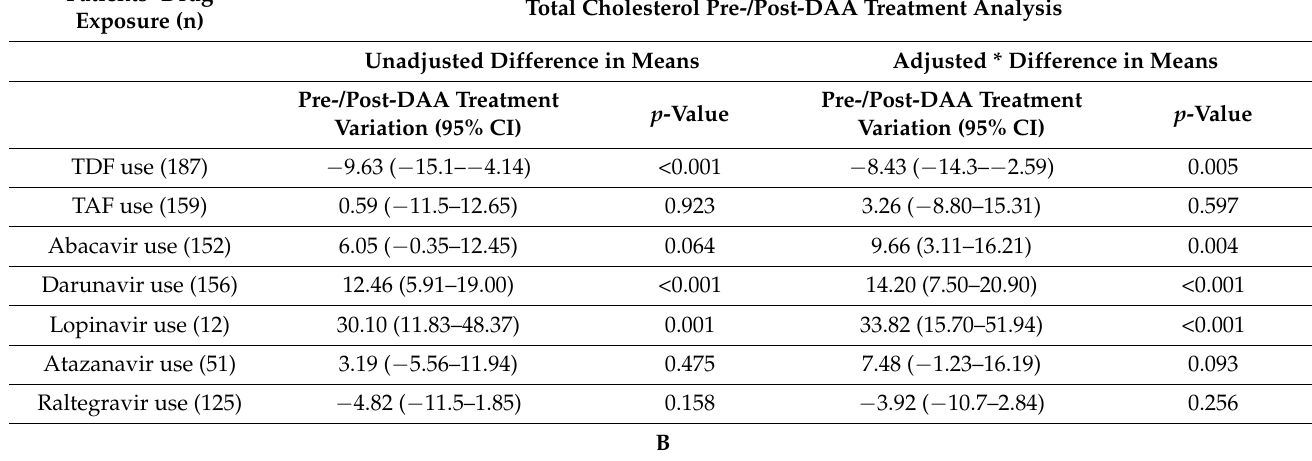
Table 4. Mean changes in biomarkers from fitting an ANCOVA regression model for total cholesterol (panel A), LDL cholesterol (panel B), HDL cholesterol (panel C), and triglycerides (panel D) stratified by antiretroviral drugs. TDF: tenofovir disoproxil-fumarate; and TAF: tenofovir alafenamide. * Adjusted for length of time since HIV diagnosis. A separate model for each drug was performed. Models evaluating a drug included in the PI/r class were further adjusted for use of other drugs in the class (e.g., the DRV/r model was controlled for use of ATV/r and